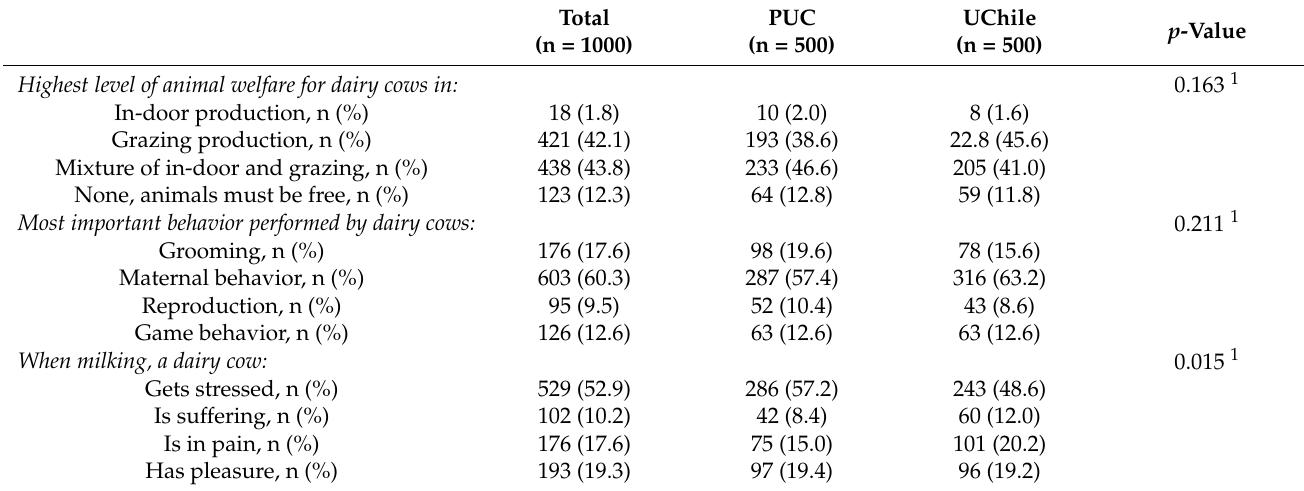
Table 6. Chilean university students’ perceptions toward dairy cows’